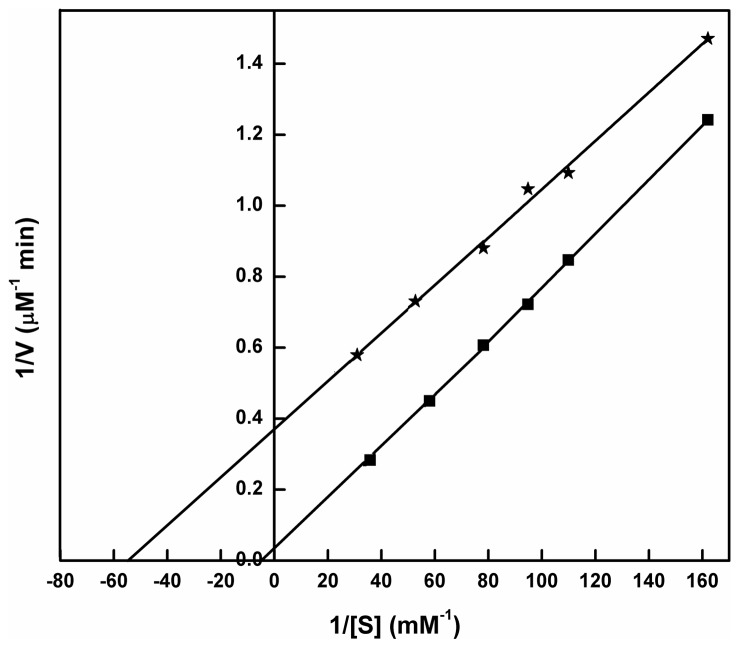
Double reciprocal plot or Lineweaver-Burk plot of catalase – H2O2 (▪) and catalase+EGCG – H2O2 (*) reactions.